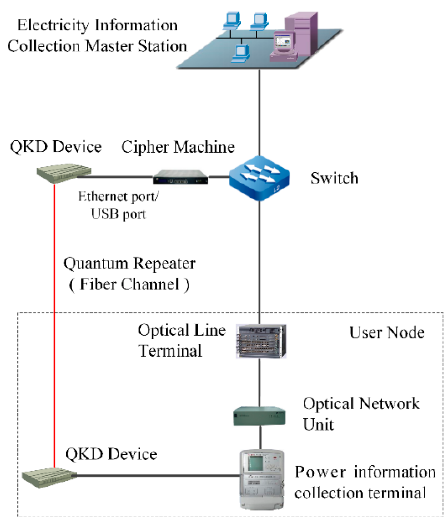
Figure 8. Electricity information collection based on QKD.